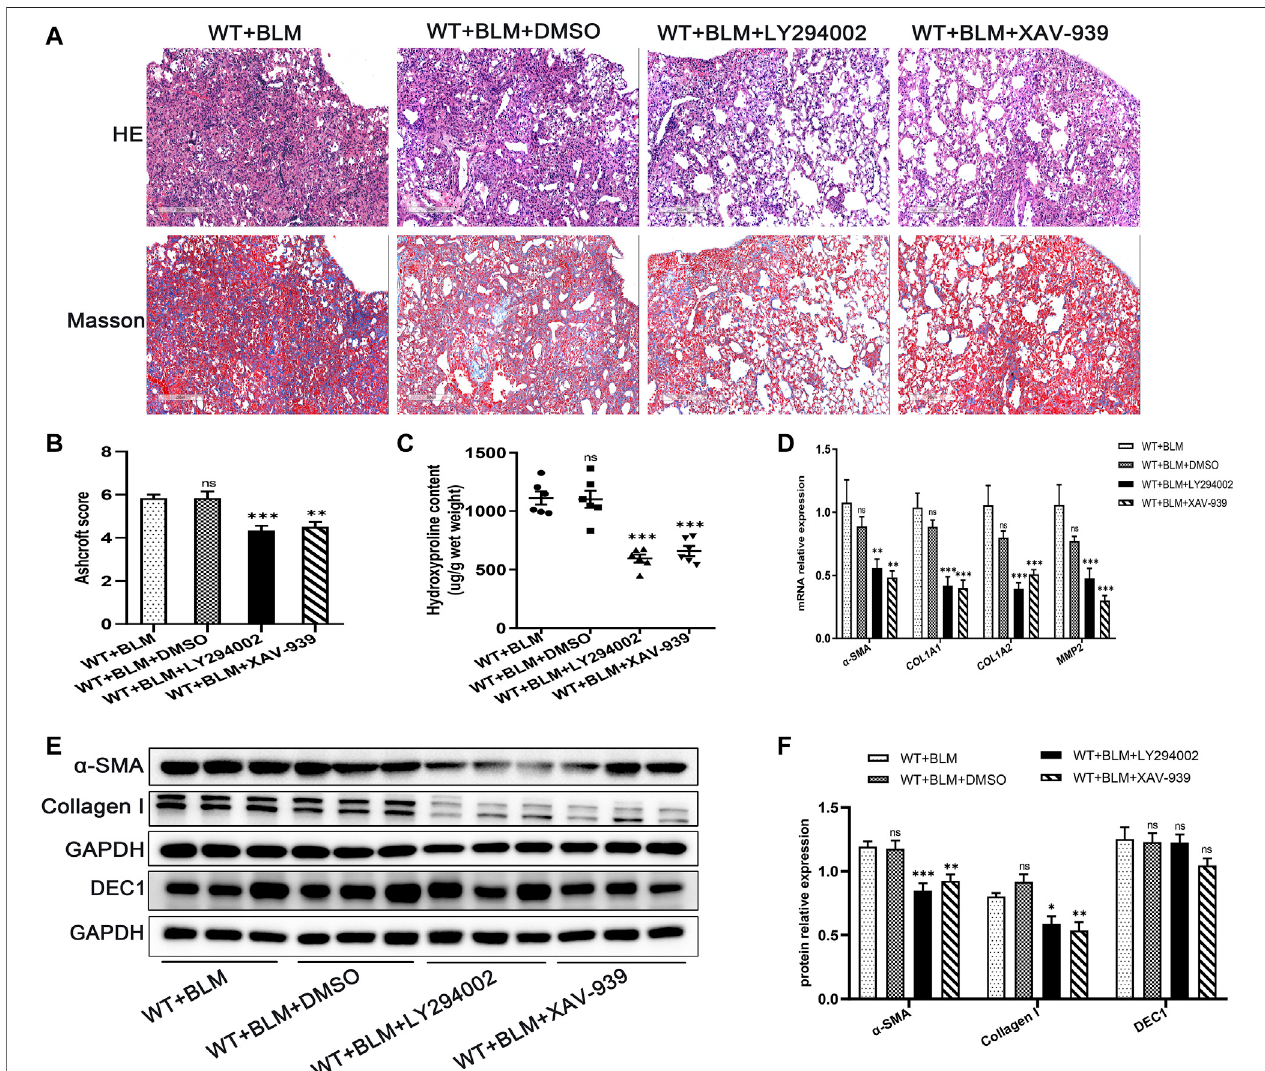
FIGURE5| InhibitionofthePI3K/AKT/GSK-3 β / β -cateninsignalingpathwayrelievedBLM-inducedPF.WTmiceadministratedbyBLMweretreatedwithorwithout LY294002 or XAV-939 or DMSO for 21 days. (A) Representative HE staining and Masson ’ s trichrome staining in the lung tissues in mice. Scale bar = 200 μ m. (B) Ashcroft score was measured using the Ashcroft method. (C) Total collagen levels were assessed by measuring hydroxyproline content in the lung tissues of mice. (D) The mRNA expression of α -SMA, COL1A1, COL1A , and MMP2 in the lung tissues of mice were measured by qRT-PCR. (E) The protein expression of α -SMA, collagen I and DEC1 in the lung tissues of mice were detected by western blotting. (F) Statistical analysis of relative expression levels of proteins in E. n = 6. Data are shown as the mean ± SEM. Statistical analysis was performed by one-way ANOVA. * p < 0.05, ** p < 0.01, *** p < 0.001, ns p >